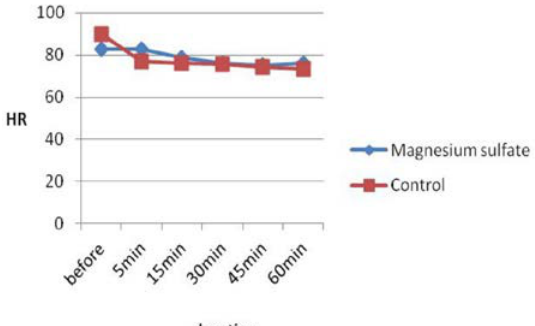
Figure 1. Illustrates the trend of heart rate variations in both case and control groups Table 2. The frequency (percentage) of vasospasm, mortality and morbidity in magnesium sulfate and control groups